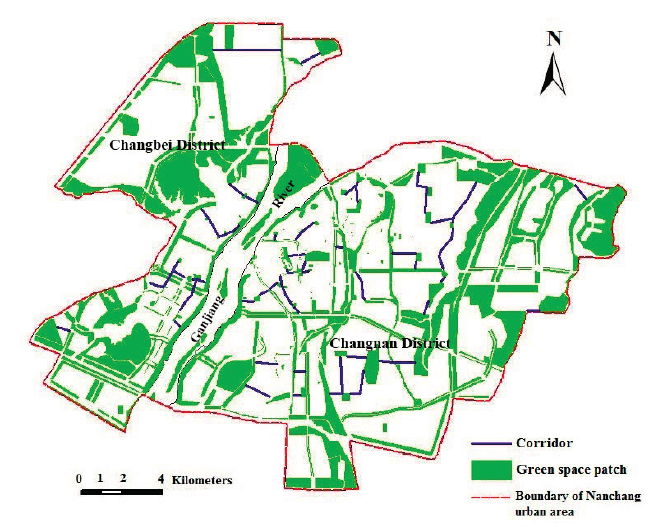
Figure 3. Distribution of ecological nodes and corridors of the Nanchang urban area.